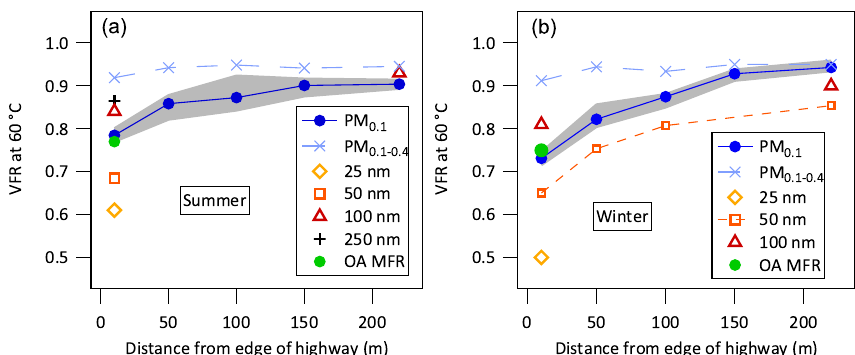
Figure 1. Campaign-average downwind evolution of volume fraction remaining (VFR) of near-road particles after heating at 60 ◦ C in a TD (Rt = 30s) during (a) summer and (b) winter. VFR of size-selected particles (e.g., 25, 50, 100, 250nm) obtained from V-TDMA measurements. VFR of PM 0 . 1 and PM 0 . 1 − 0 . 4 estimated from integrated SMPS volume between 10 and 100nm and between 100 and 400nm, respectively. OA MFR was measured using a TD–ACSM system (Rt = 30s) in the near-road trailer. The shaded area represents the interquartile range of all measurements for each season.